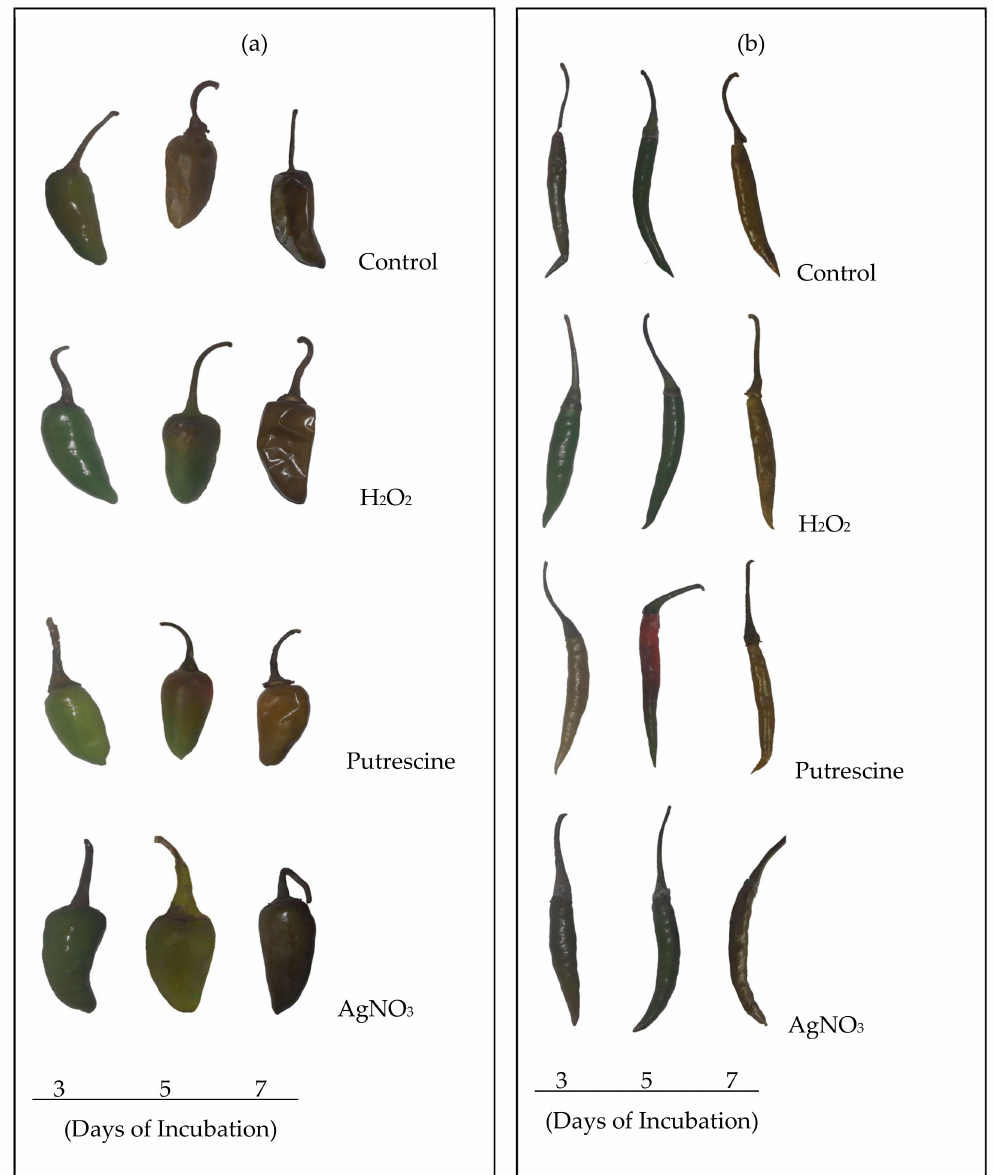
Figure 1. Morphological changes of chili fruits: cv . Bullet ( a ) and cv . Tejaswani ( b ) under various treatments, i.e., H 2 O 2 , putrescine, and AgNO 3 after 3, 5, and 7